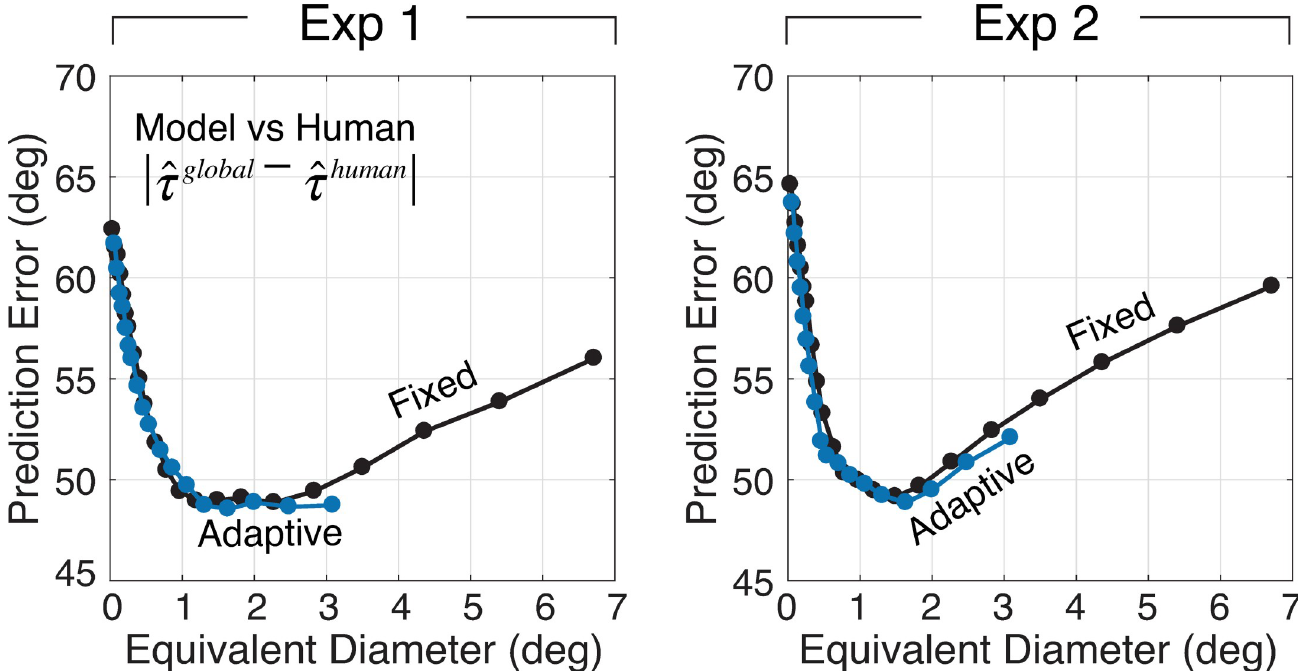
Fig 10. Prediction error of adaptive elliptical pooling model. Human prediction error (model estimate vs. human estimate) is plotted (blue) as a function of pooling area (i.e., equivalent diameter). For comparative purposes, performance is also plotted for the fixed circular pooling model (black; same data as Fig 8).